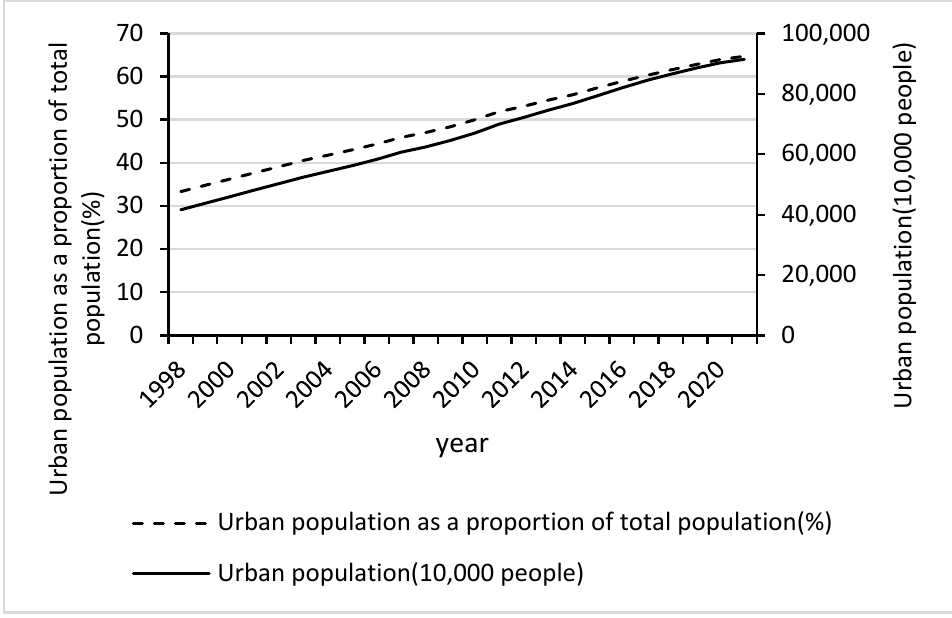
Urban population as a proportion of total population(%) Urban population(10,000 people) Figure 1. China’s urbanization process 1 . Figure 1. China’s urbanization process 1